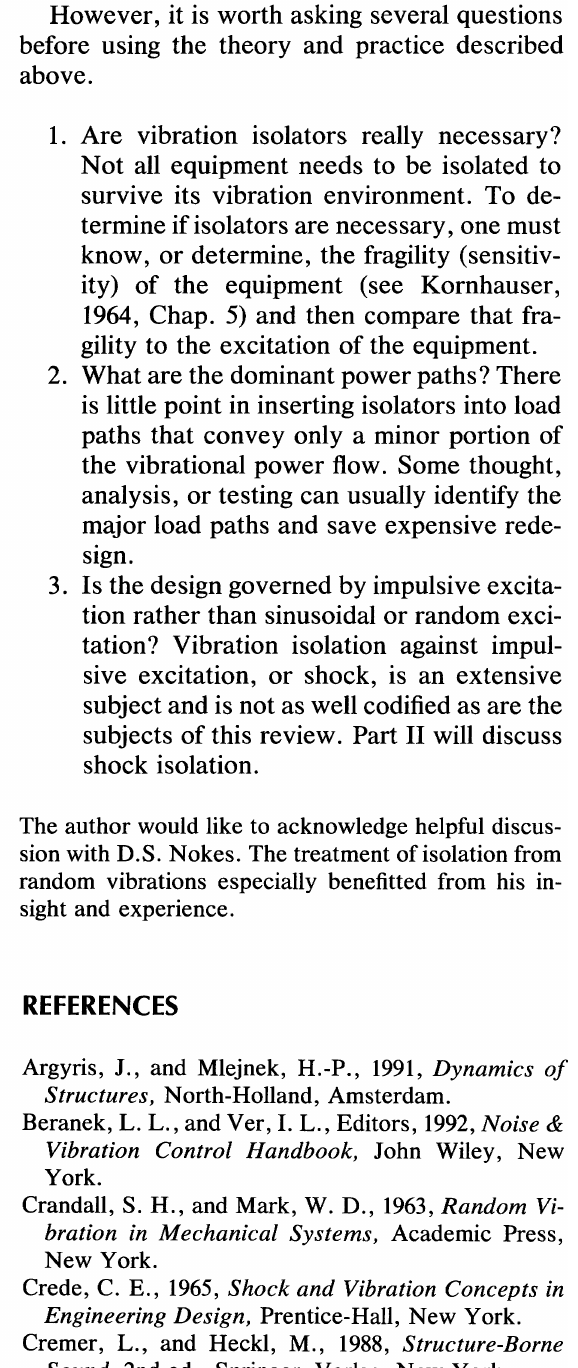
FIGURE 14 Power spectral density (PSD) of a wide band input excitation (PSD-IN) and the responses (PSD-X1 and PSD-X2) of a two-stage isolation